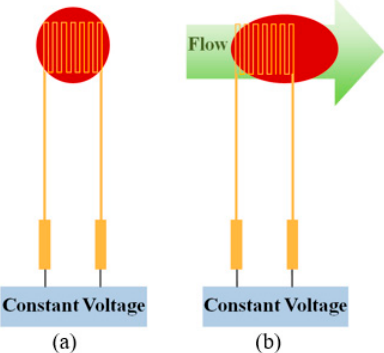
Figure 1. Sensing principle of a micro flow sensor: ( a ) no fluid through; ( b ) fluid through.